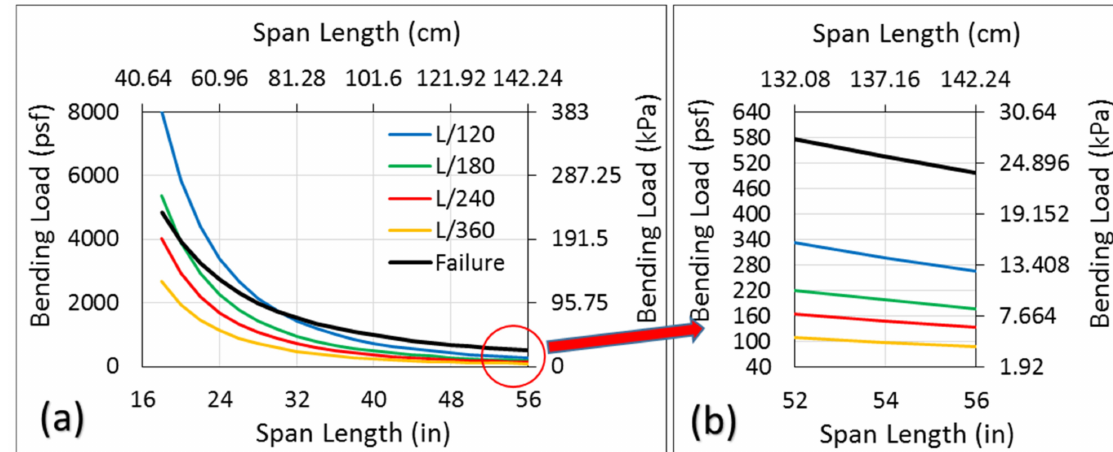
Figure 9. ( a ) Maximum bending load for different span lengths without passing the deflection limits ( b ) a blow-up of the circle area in part